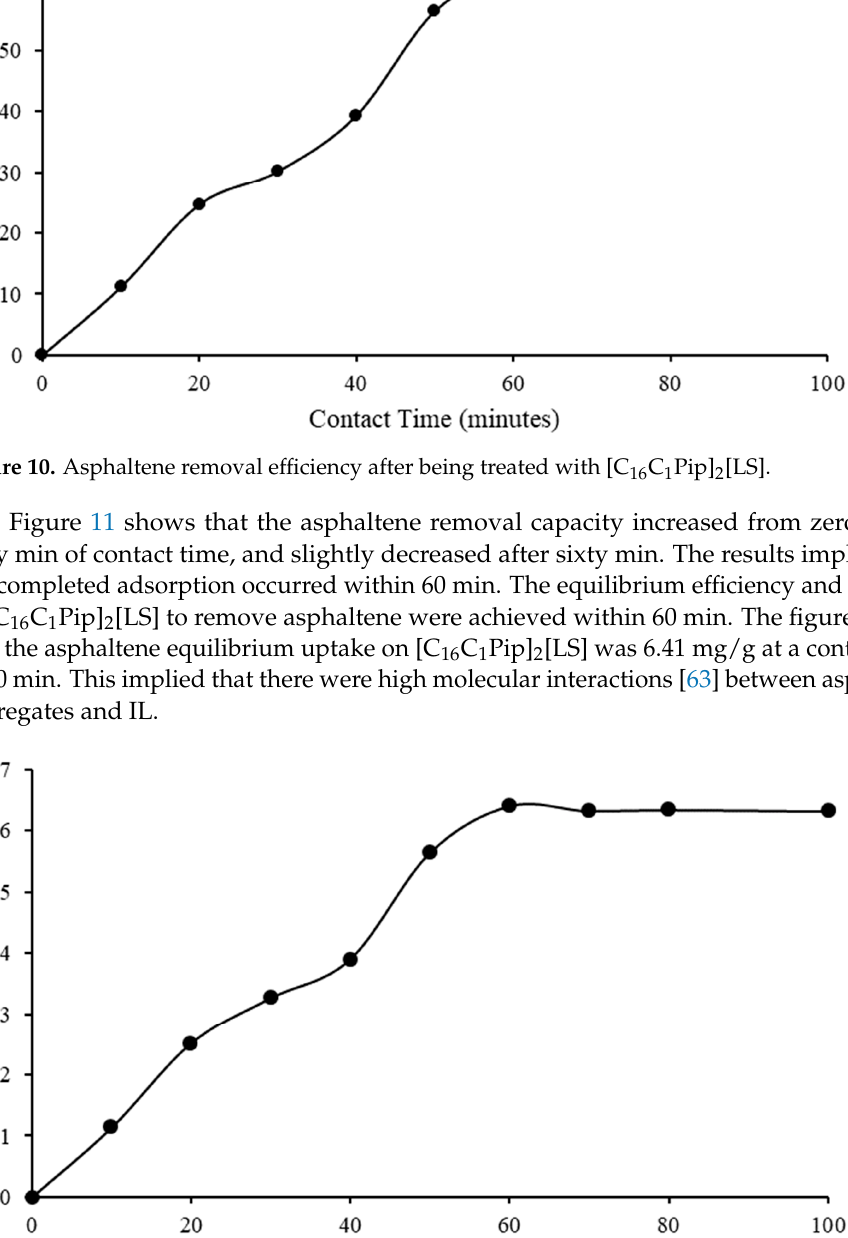
Table 5. Parameters of the kinetic model.